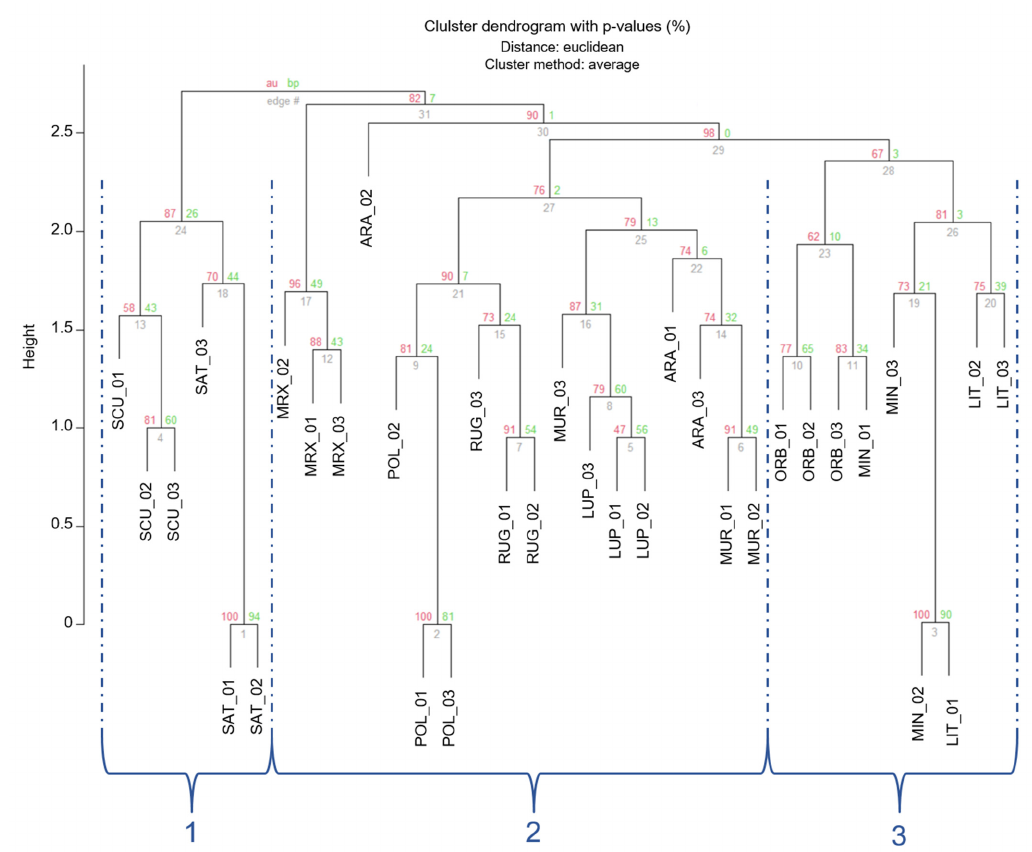
M. murex . Genes 2021 , 12 , x FOR PEER REVIEW